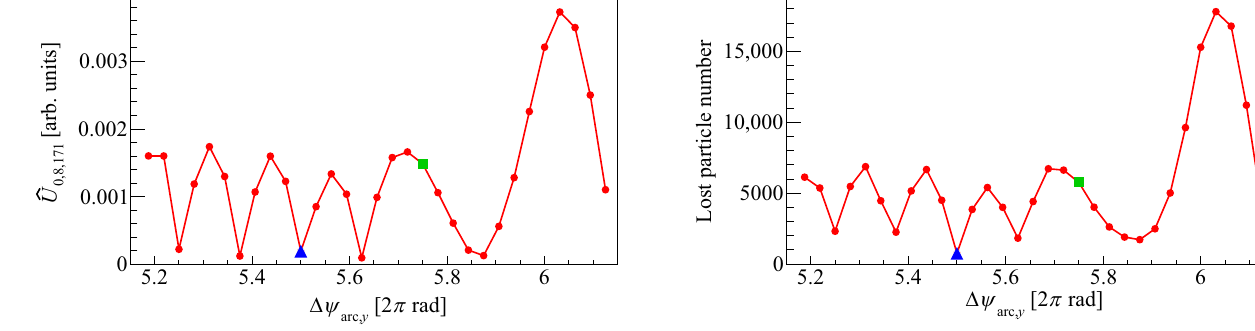
ˆ U FIG. 8. Simulated numbers of lost particles from turns 500 to FIG. 7. Calculated potential 0 ; 8 ; 171 corresponding to the 24,100. The green square and blue triangle represent the result of resonance 8 ν y ¼ 171 . The green square and blue triangle the present FX optics and new optics, respectively. represent the result of the present FX optics and new optics, respectively.